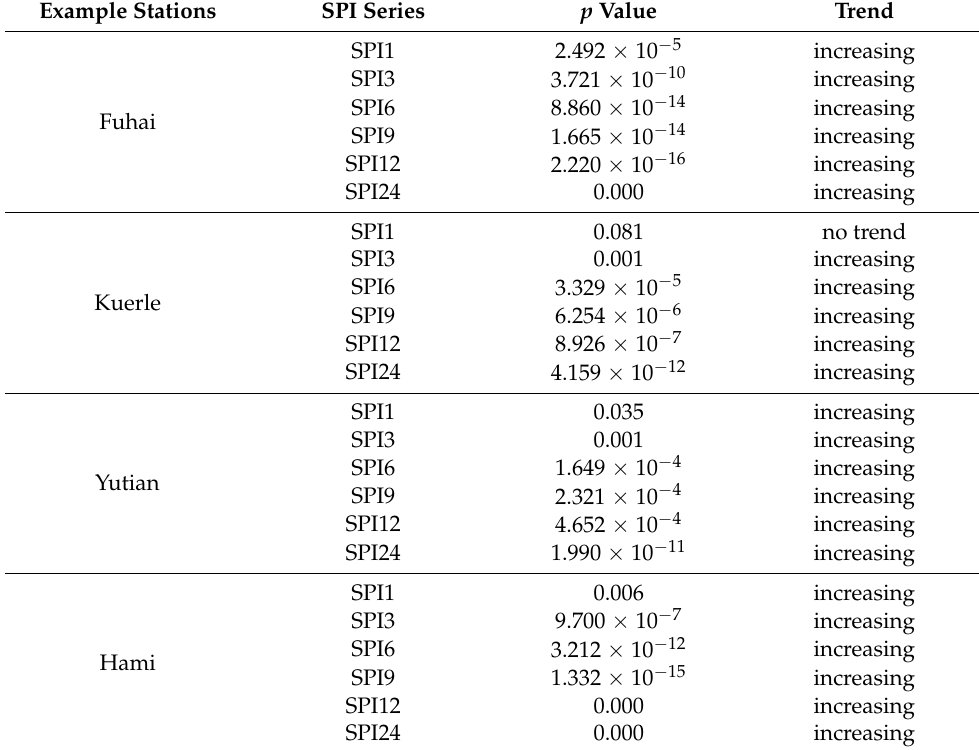
Table 2. Mann–Kendall trend test for SPI